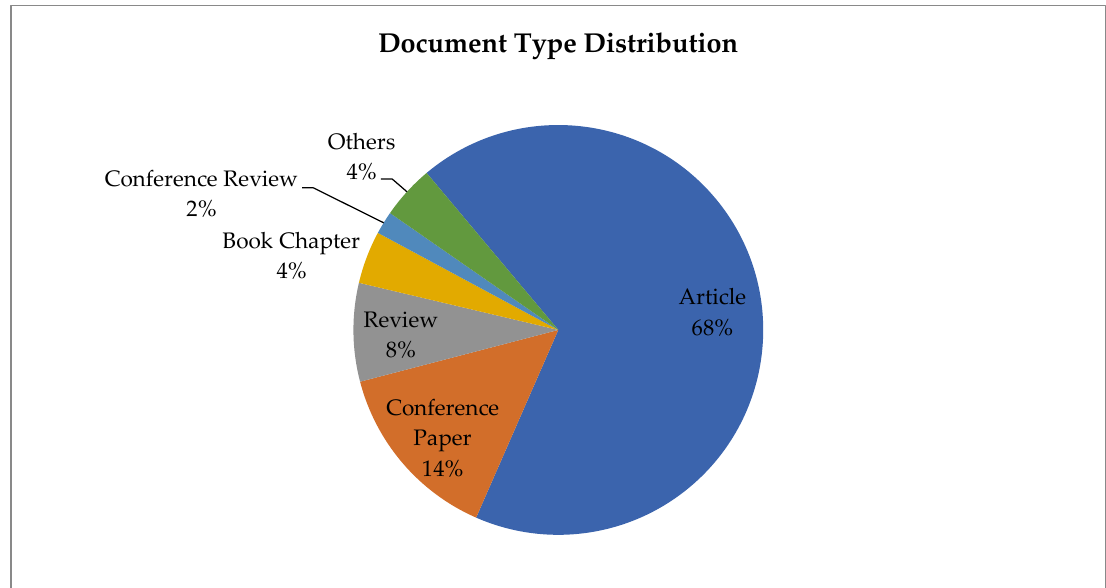
Figure 2. Frequency of the types of documents from 1978 to 2018.